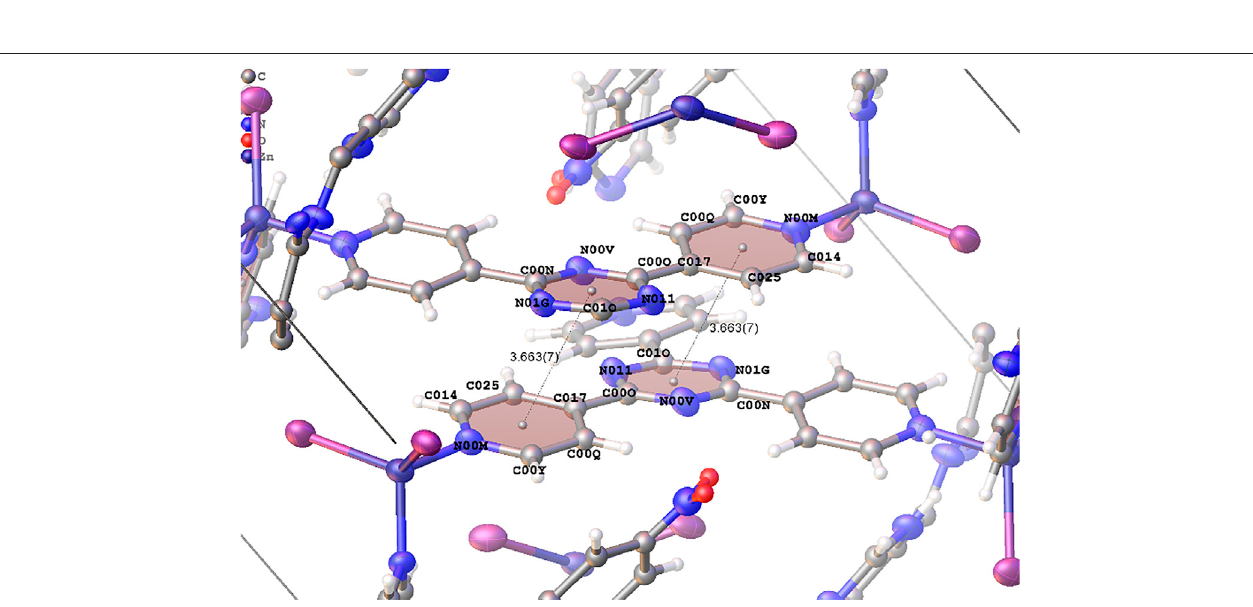
FIGURE3| Thestructure model, guestmolecule conformation, and F o density map (drawn in0.5e-/Å 3 level)of (A) 1-Nitrobenzene, (B) 1-Cyclohexane, and (C) 1- Guaiazulene.